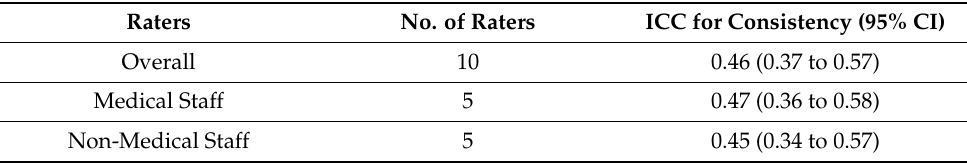
ICC = intraclass correlation coefficient; CI = confidence